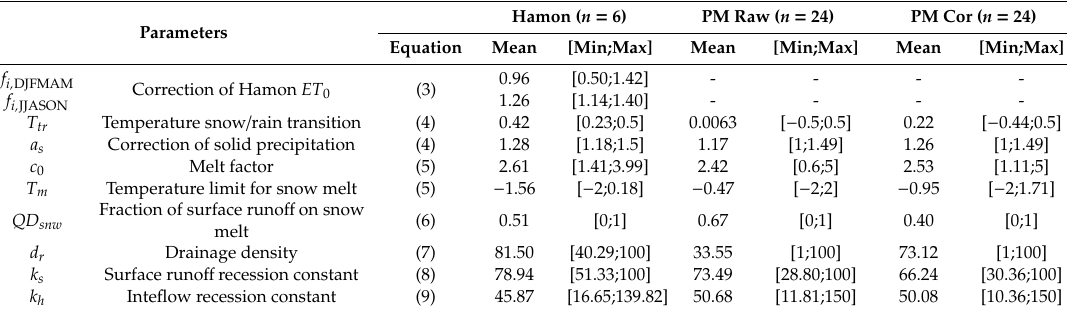
Table 4. Optimized values of WaSim-ETH free parameters.